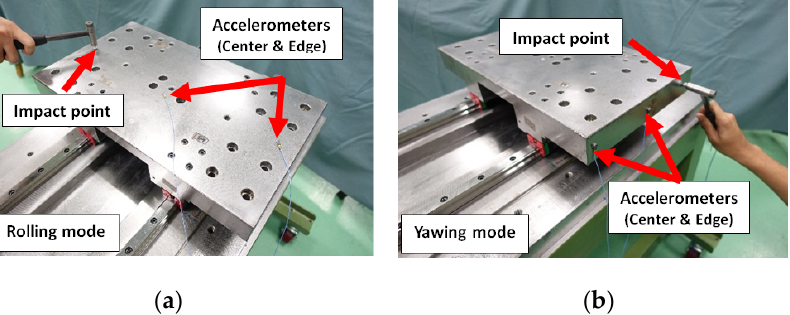
Figure 5. Schematics of vibration test of stage: ( a ) rolling mode and ( b ) yawing mode.